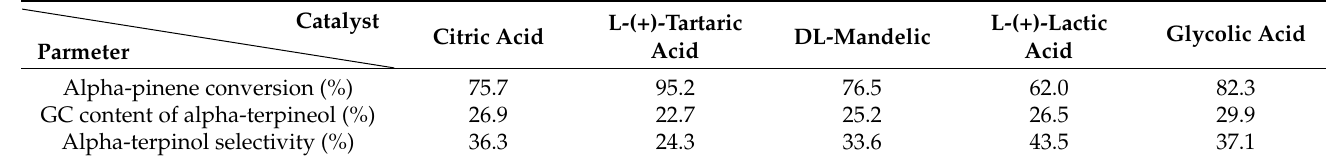
Table 1. Comparison of catalytic performance of AHAs with acetic acid as the additive.